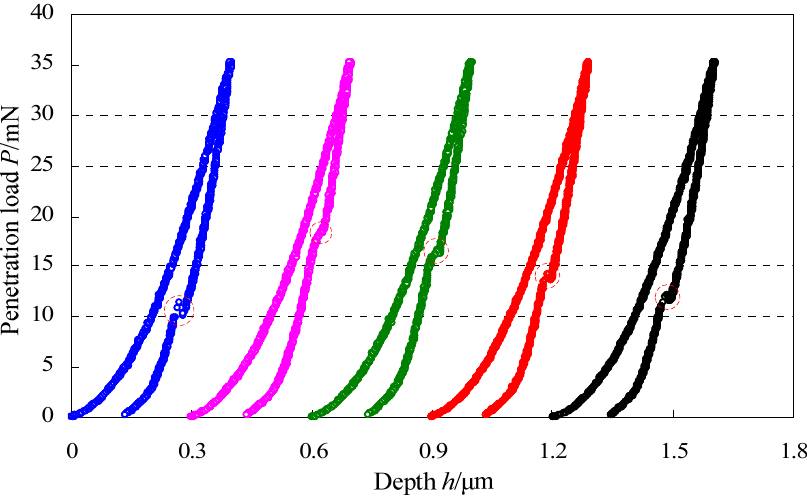
Figure 5. Load-depth curves of single crystal silicon with the same maximum penetration load of 35 mN and the same loading/unloading rate of 0.70